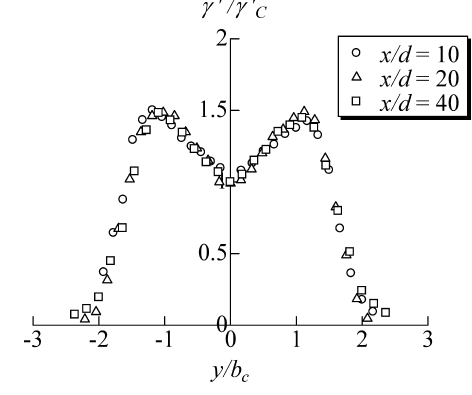
Fig. 5 Cross-streamwise profiles of r.m.s. value of concentration fluctuation of nonreactive